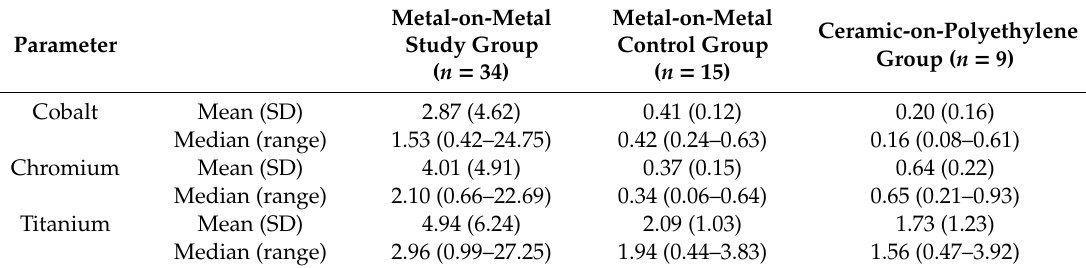
Table 3. Results of blood metal ion analysis (the values are given in µ g / L).